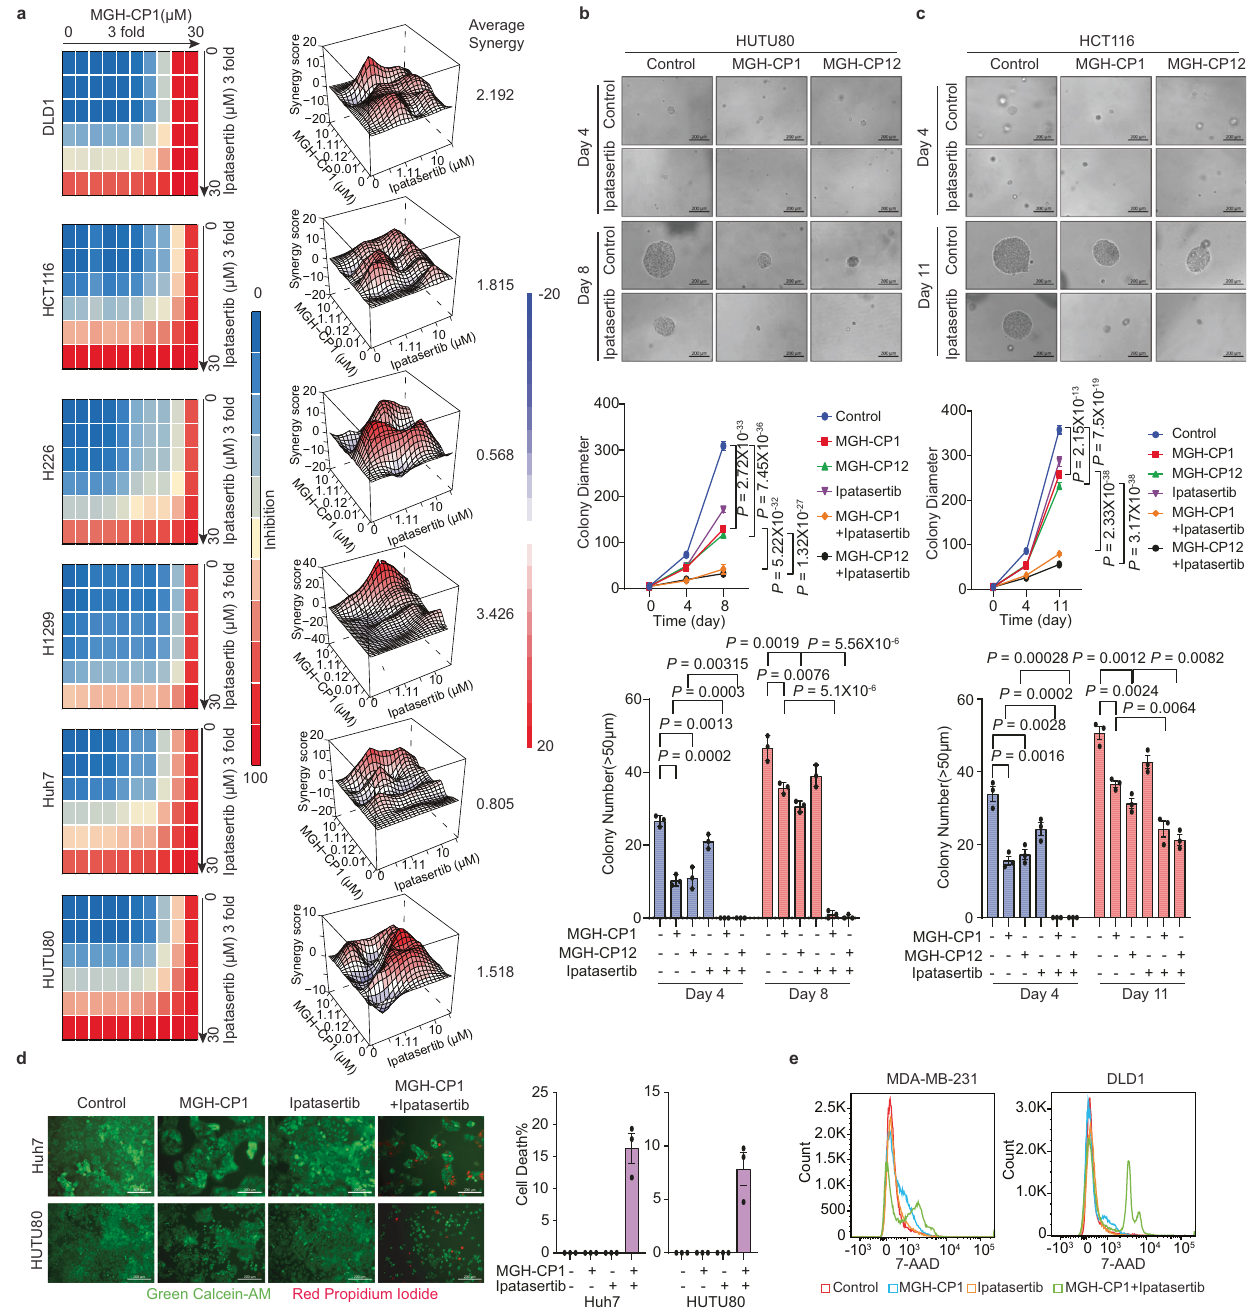
Fig. 6 | Synergistic effects of TEAD and AKT inhibitors combination in cancer cells. a Drug combination experiments using MGH-CP1 and AKT inhibitor ipata- sertib, and Heatmaps show color-coding as percentage of cell viability normalized to untreated controls. Heatmaps of Bliss score for MGH-CP1 and ipatasertib com- bination were shown. b Representative images in 3D tumor cultures of HUTU80 cells treated with MGH-CP1, MGH-CP12, ipatasertib or combination. Colony dia- metersweremeasuredtoassessthetumorgrowthwithinhibitors( n =51,53,59,33, 44, 75 colonies for control, CP1, CP12, ipatasertib, CP1 with ipatasertib, and CP12 with ipatasertib, respectively at day 4, n =104, 94, 75, 97, 74, 77 colonies for the same sample order as above at day 8). Colony numbers were determined ( n =3 biological repeats). Scale bar, 200 µ m. c Representative images in 3D tumor cul- tures of HCT116 cells treated with MGH-CP1, MGH-CP12, ipatasertib or